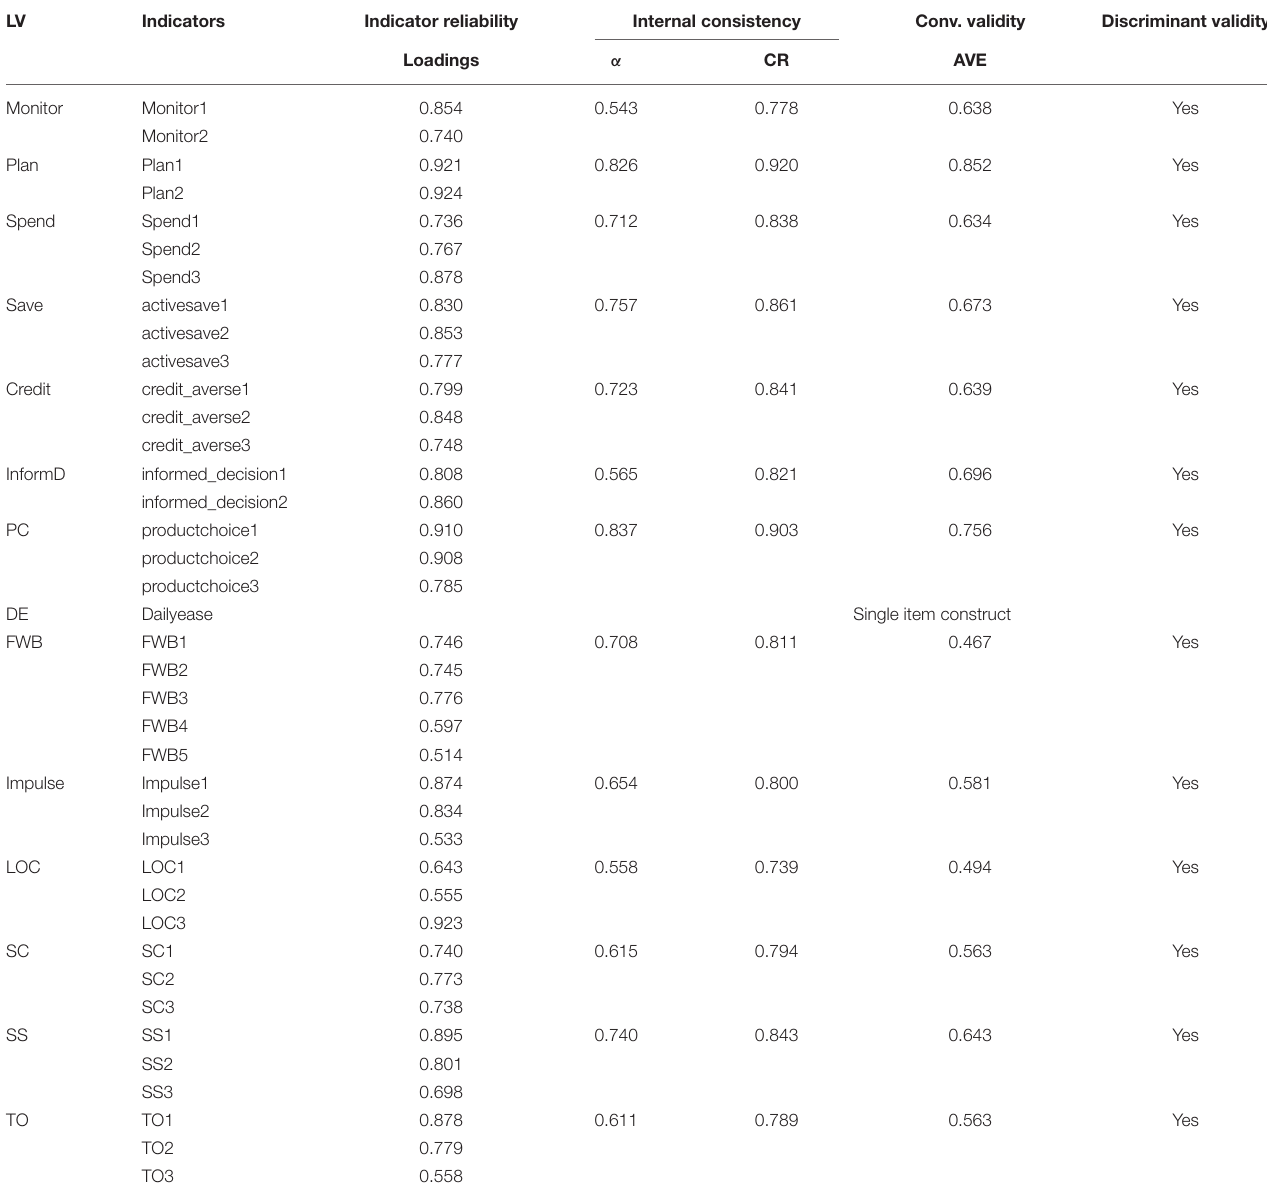
TABLE 3 | Summary of test results for reflective measurement